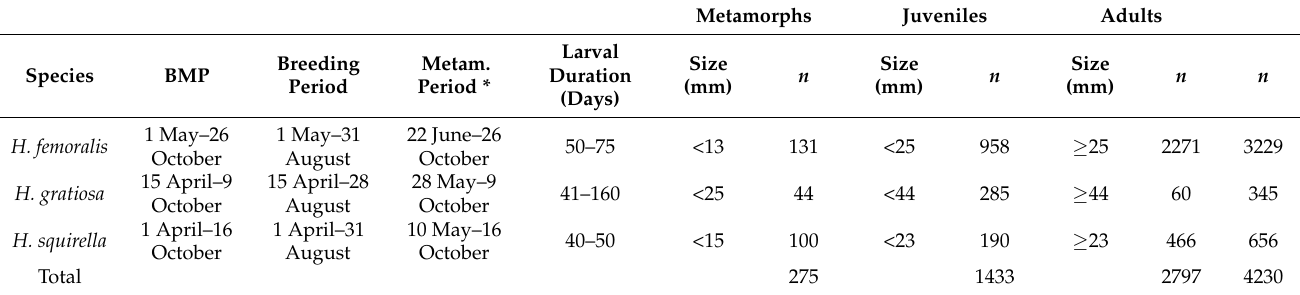
Table 1. Size cutoffs (SVLs), breeding-to-metamorphosis periods (BMPs), larval duration [10,24], and sample sizes (first captures) for each study species, Ocala National Forest, Marion County, Florida. Metamorphs Juveniles Adults Metam. Period *